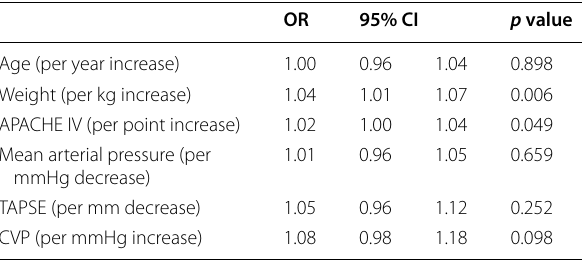
Table 3 Sensitivity analysis with central venous pressure in the multivariate model ( n =